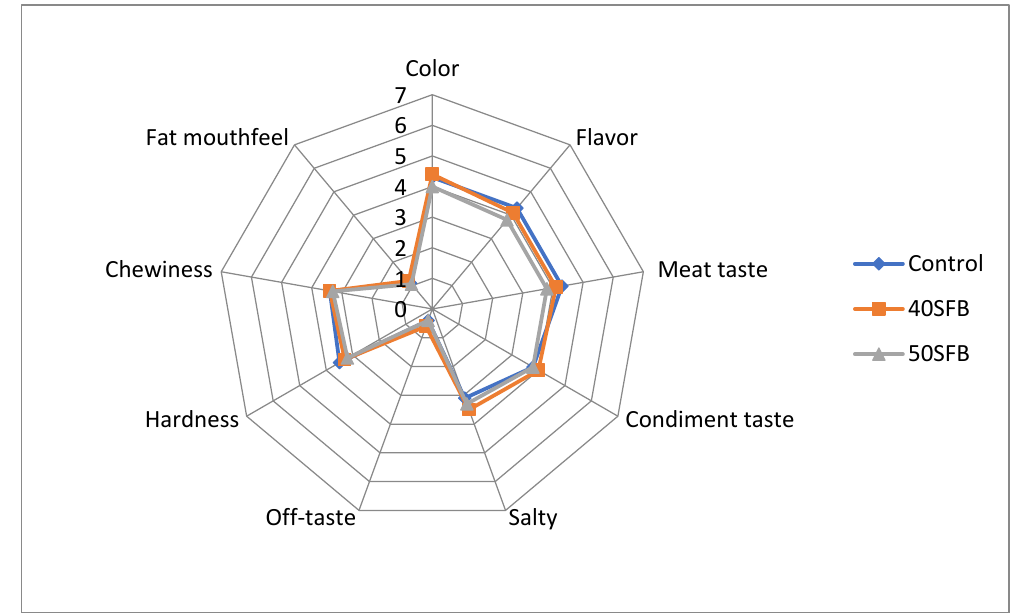
Figure 2. Sensory evaluation of chicken sausages [control, 40SFB (40% substitution of chicken skin by fatty byproducts and 50SFB (50% substitution of chicken skin by fatty byproducts)].